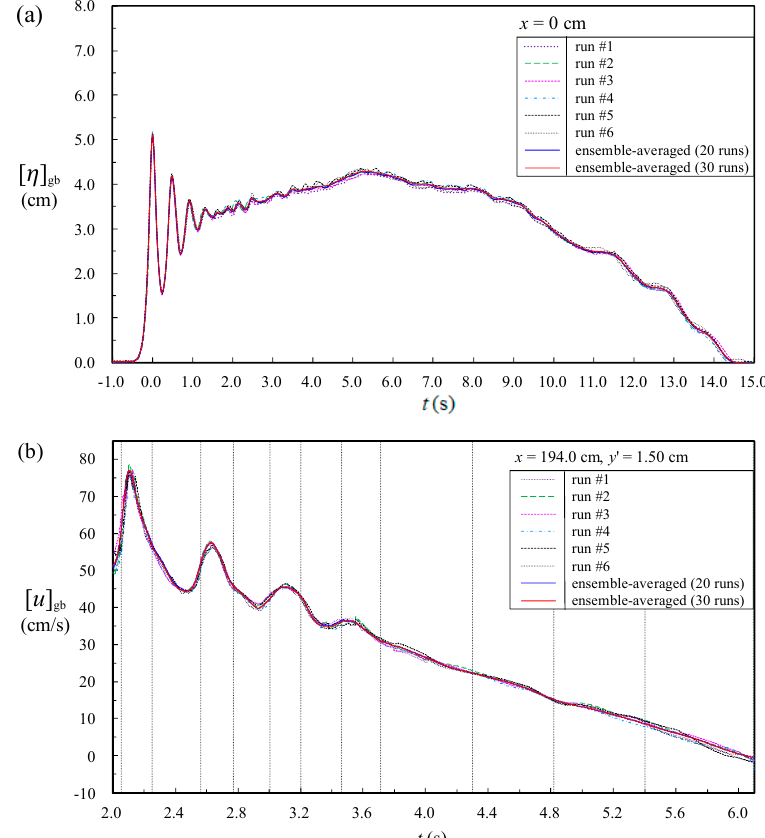
Figure 3. ( a ) Comparison of free surface elevations among six different repeated runs and ensemble-averaged result for 30 repeated runs at x = 0; ( b ) comparison of time series of horizontal velocity among six distinct runs and ensemble-averaged result for 30 repeated runs at x = 194.0 cm and y ′ = 1.50 cm.